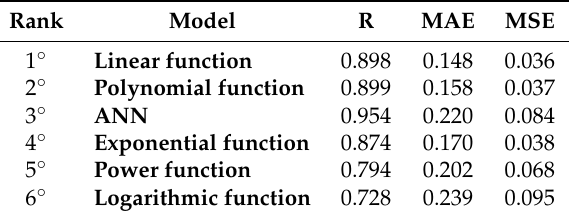
Table 9. Effective functions versus ANN for forecasting